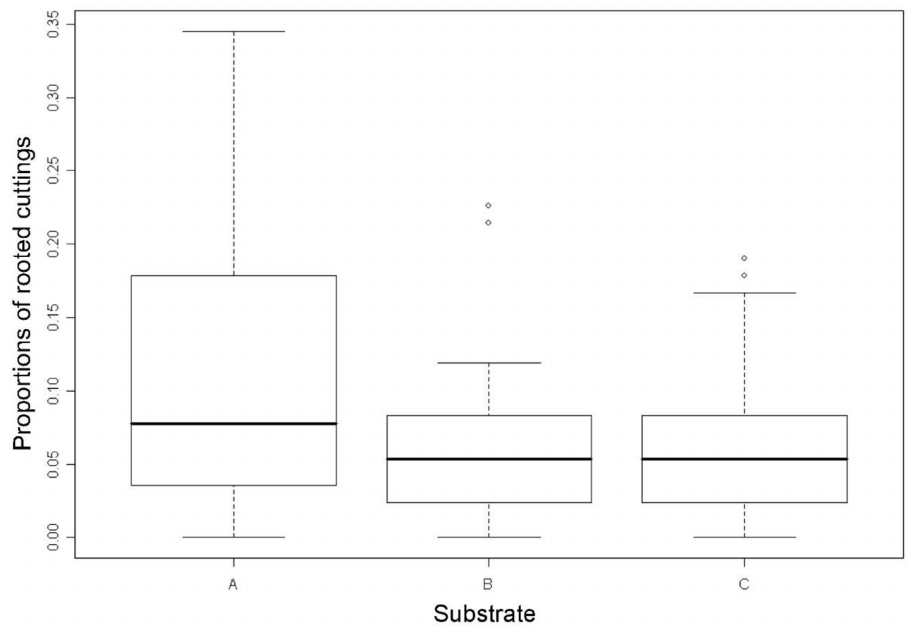
Figure 1. Box plot of the proportion of rooted cuttings from the total number of cuttings in relation to the substrate (A, B, C, see Section 2.1). The horizontal line in each box represents the median, the hinges represent the 25th and 75th percentiles, the whiskers represent 1.5 times the interquartile range and open circles represent values outside this interval.